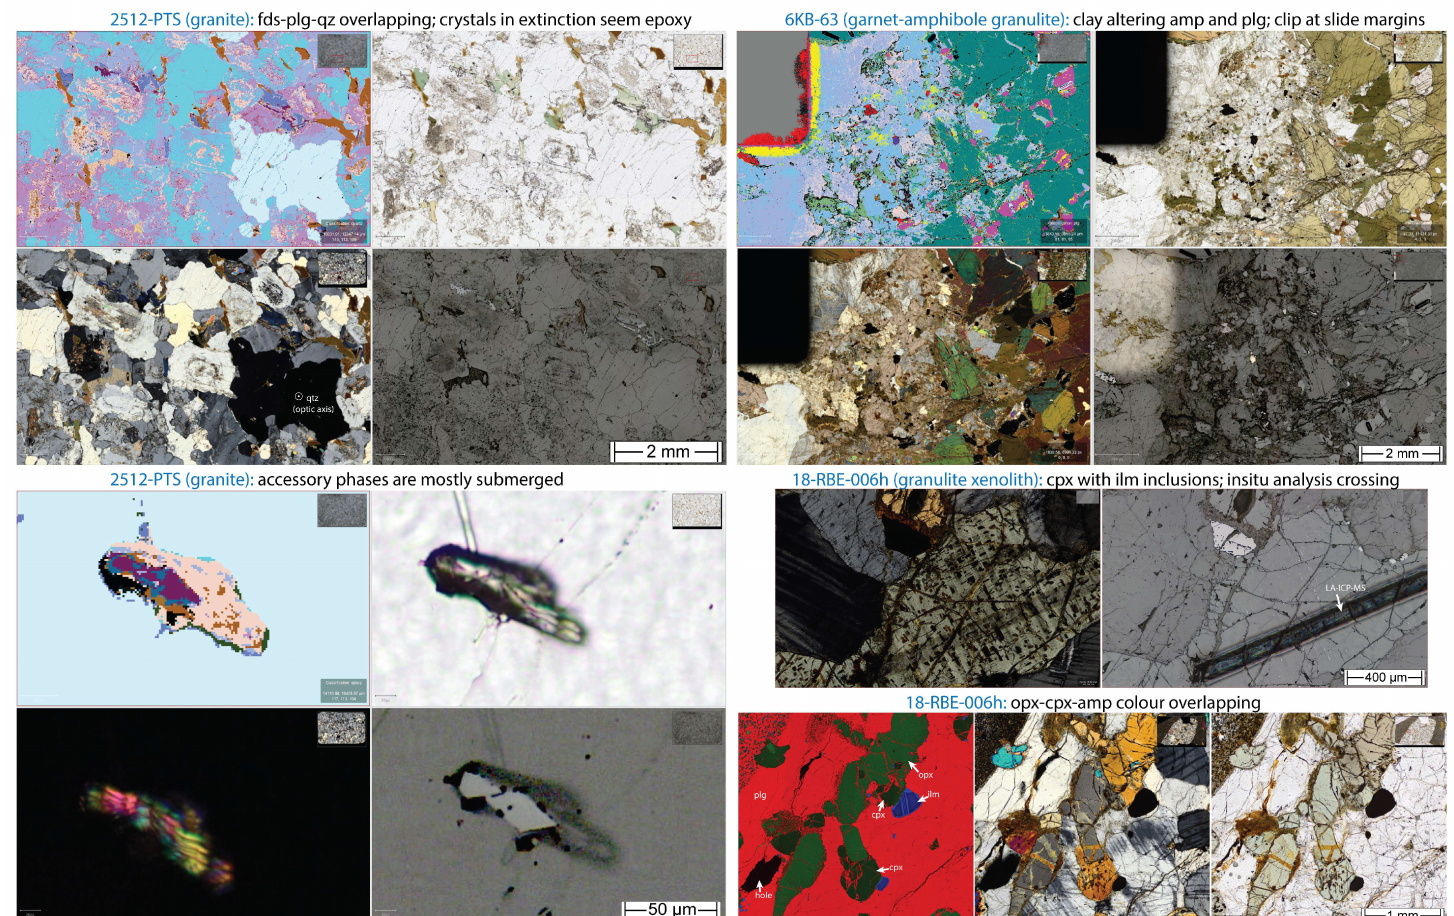
Figure 16. QuPath showing challenges in the image analysis methodology with optical microscopy (iteration #1) on thin sections. The granitoid sample panels ( left ) are shown in logical ‘multi-view’ canvas order ( top-left : phase map, bottom-left : XPL-max, top-right : PPL-max, and bottom-right : RL γ -boosted). The granulite ( top-right ) illustrates challenging secondary sheet silicate segmentation near the section margin. The pyroxene-plagioclase granulite xenolith ( bottom-right ) displays the difficulty of separating orthopyroxene from clinopyroxene depending on crystallographic